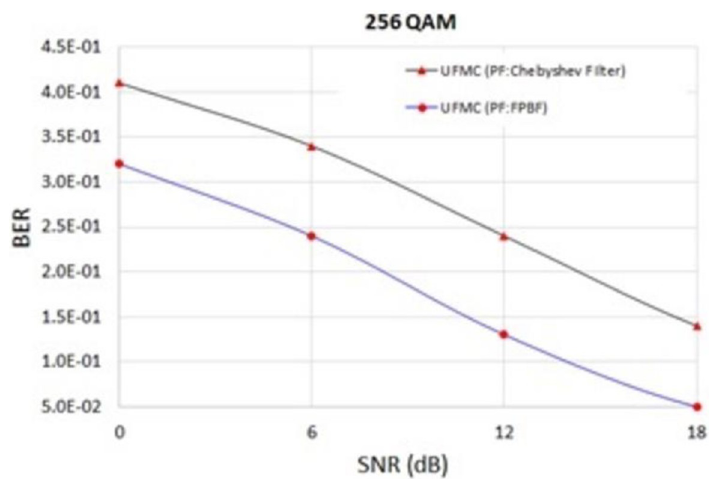
Fig 10. BER of FPBF and Chebyshev filter based UFMC at different SNR.